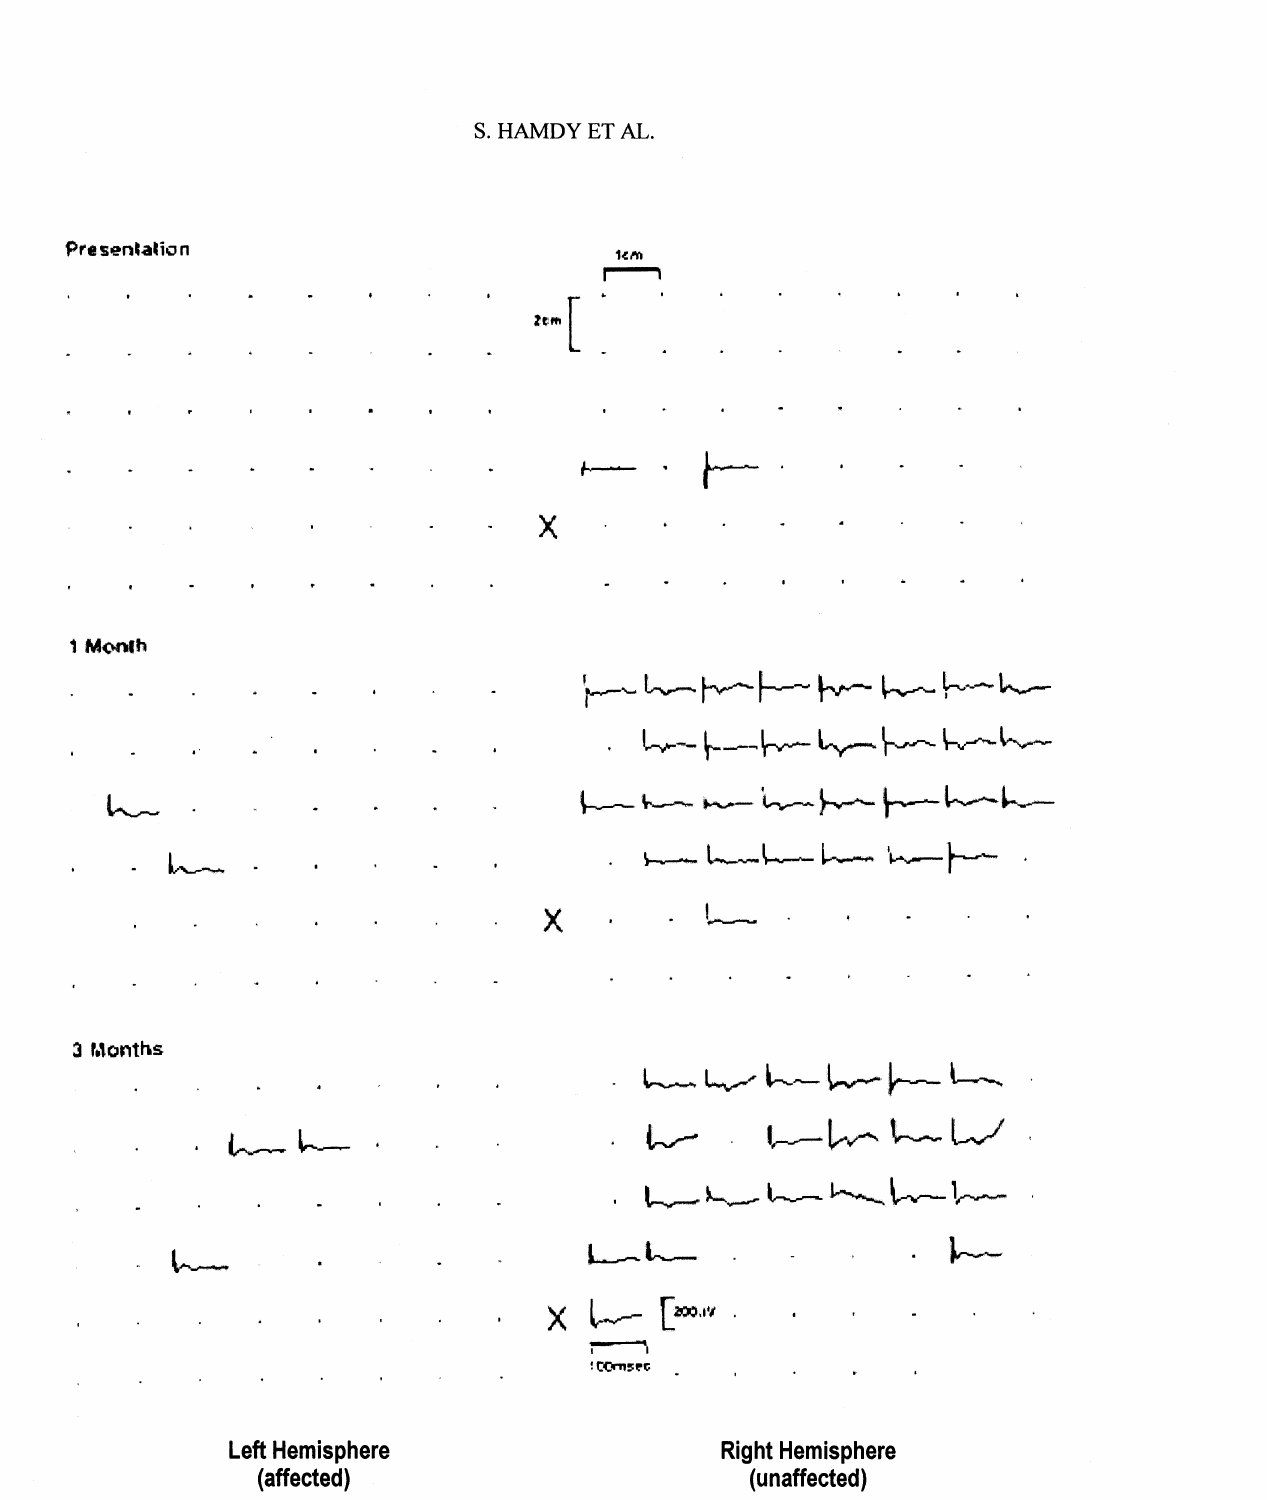
Left Hemisphere Right Hemisphere (affected) (unaffected) Changes in the excitability of cortical projections to pharynx following recovery after a dysphagic stroke. The EMG responses are shown after stimulation of each point on the scalp in a single patient at presentation (top), and then month (middle) and 3 months(bottom) after stroke affecting the left hemisphere. An ’X’ marks the vertex of the scalp. Over the period of study, the patient progressed from severe dysphagia to controlled swallowing. Note how the size of responses evoked from the unaffected hemisphere increases in size over the same period. There was little change in the size of responses evoked from the affected hemisphere. (From Hamdy et al.,